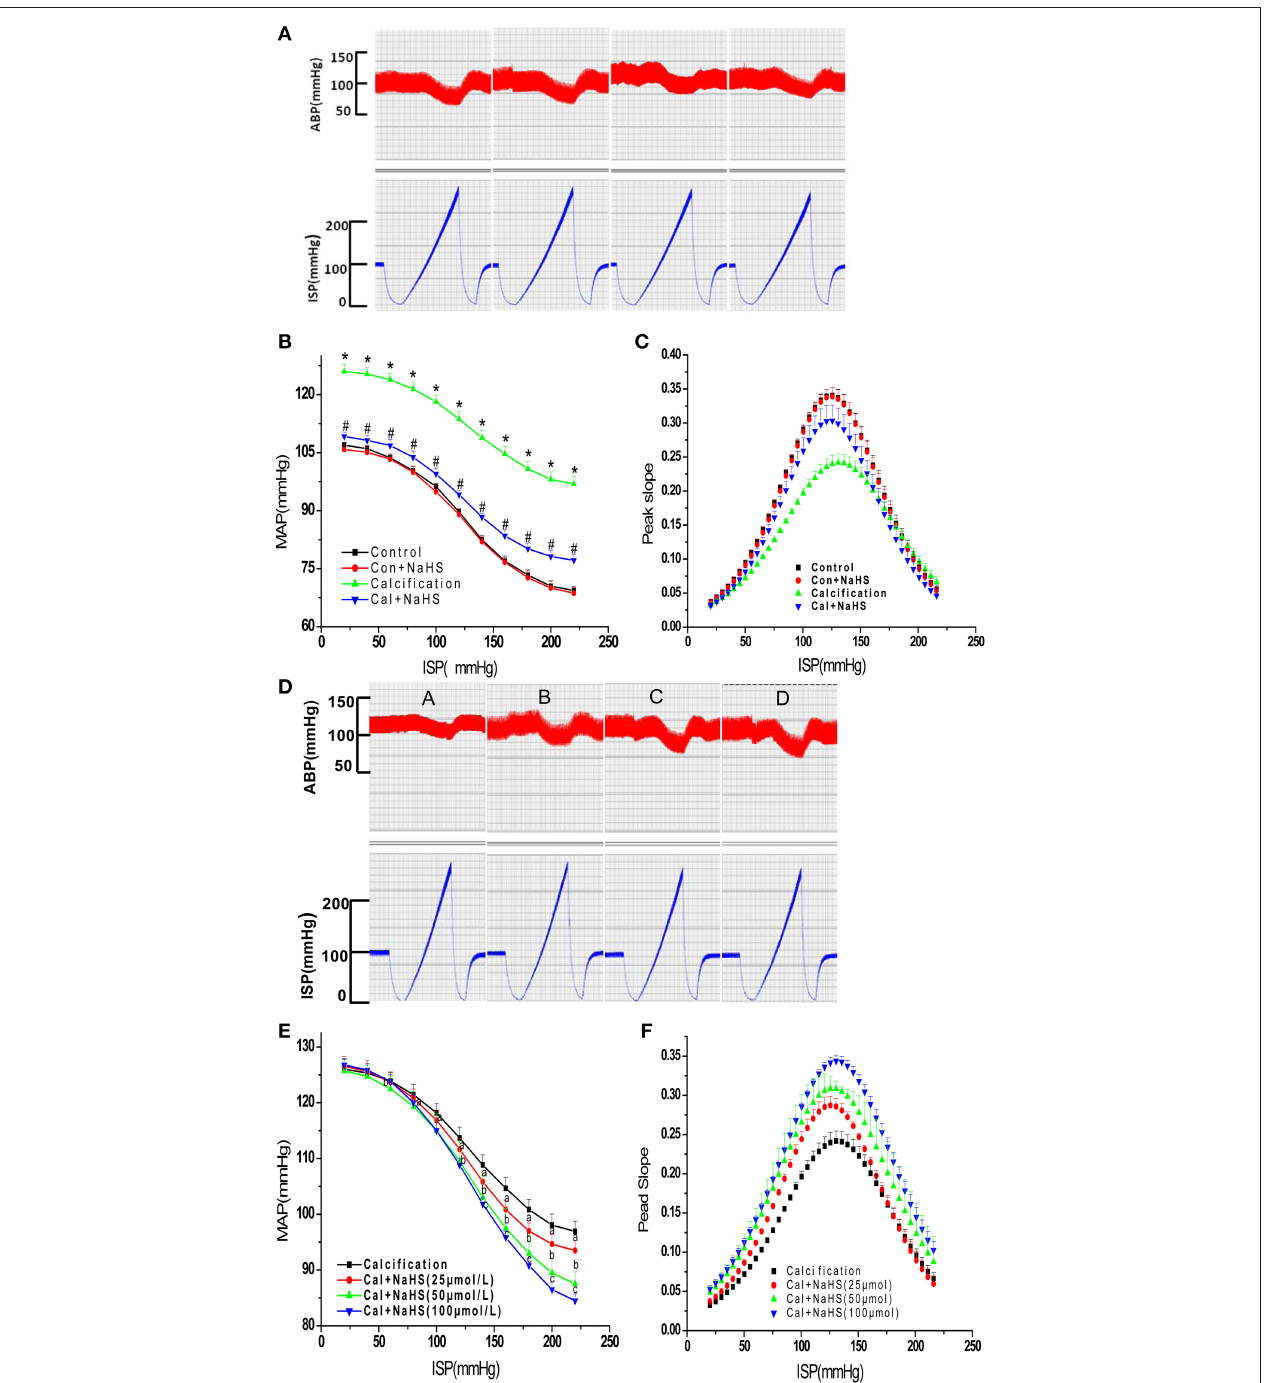
FIGURE 4 | The original recording images (A,D) , functional curves (B,E) and peak slope (C,F) of carotid sinus baroreflex. (A–C) , Effect of chronic NaHS treatment on baroreflex; (D–F) , Effect of acute NaHS treatment on baroreflax. Data are mean ± SD. * P < 0.05 vs. control; # P < 0.05 vs. Cal. ( n = 8 each